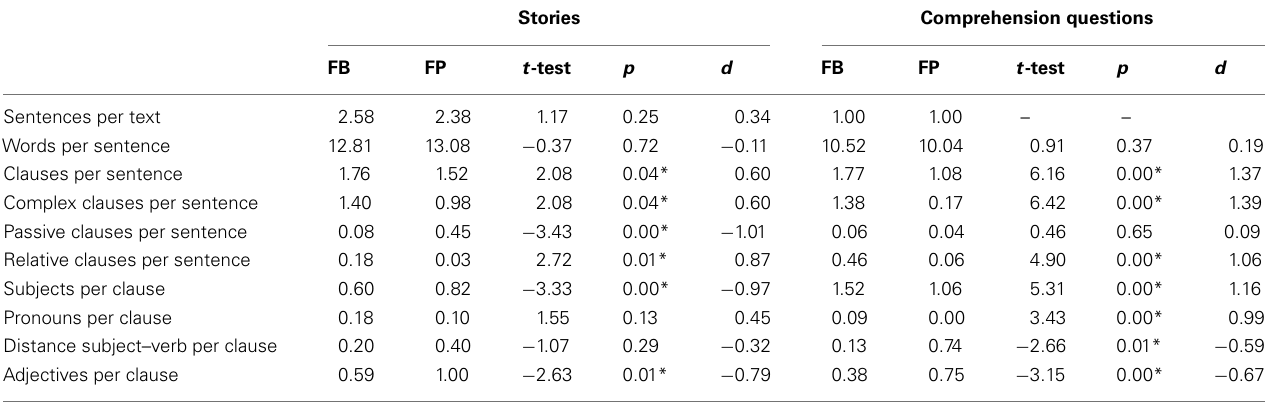
Table 1 | Linguistic indexes for both stories and comprehension